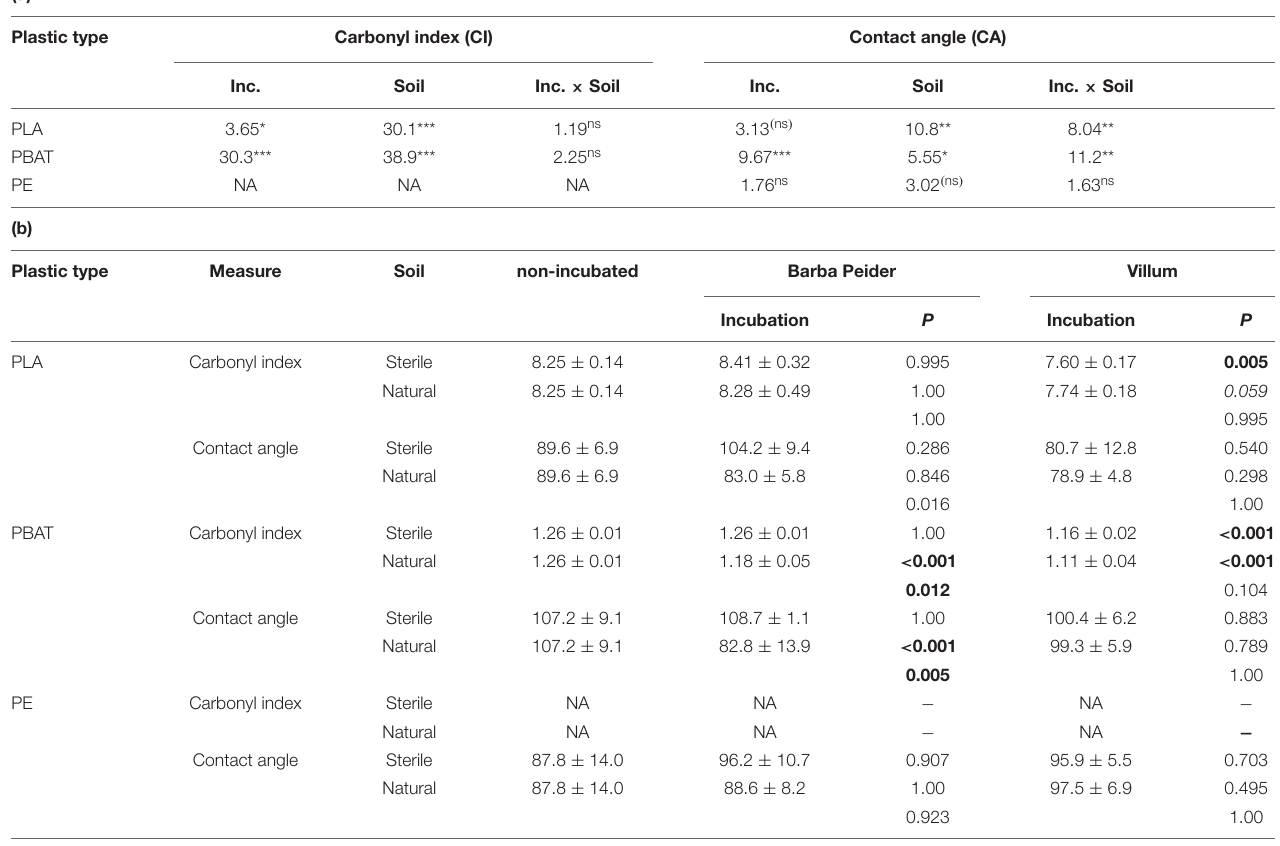
TABLE 2 | Physico-chemical characterization of plastics before and after an 8-week incubation in autoclaved (sterile) and natural (non-sterile) soil from Barba Peider or